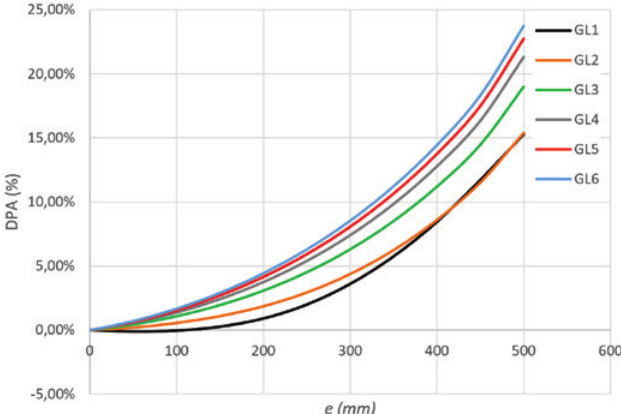
Figura 10 Curvas das diferenças percentuais acumuladas das 11 simulações dos modelos MP3DSL1